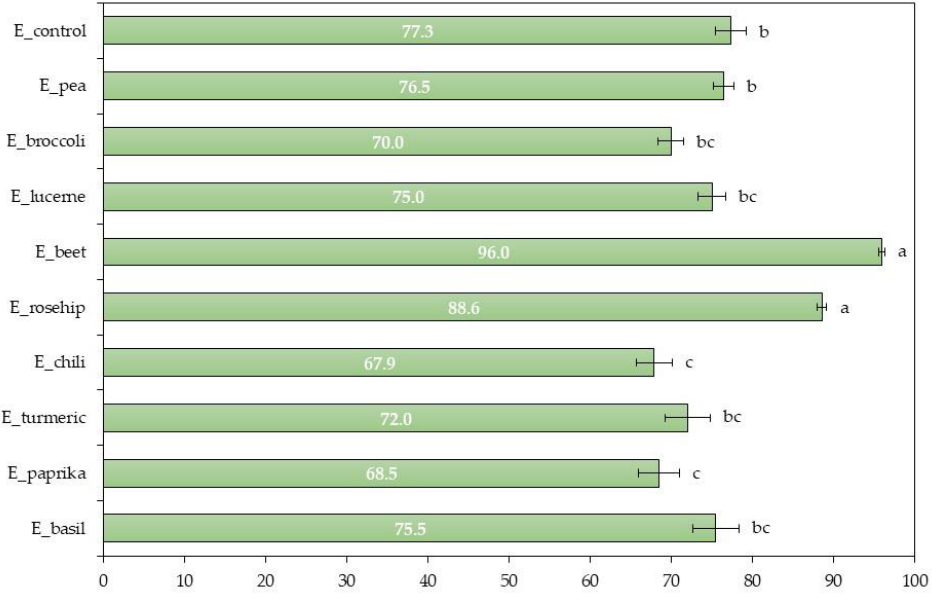
Figure 5. In vitro glycemic index of extrudate samples. Bars represent standard errors of means (n = 3), and means with different letters are significantly different ( p < 0.05).